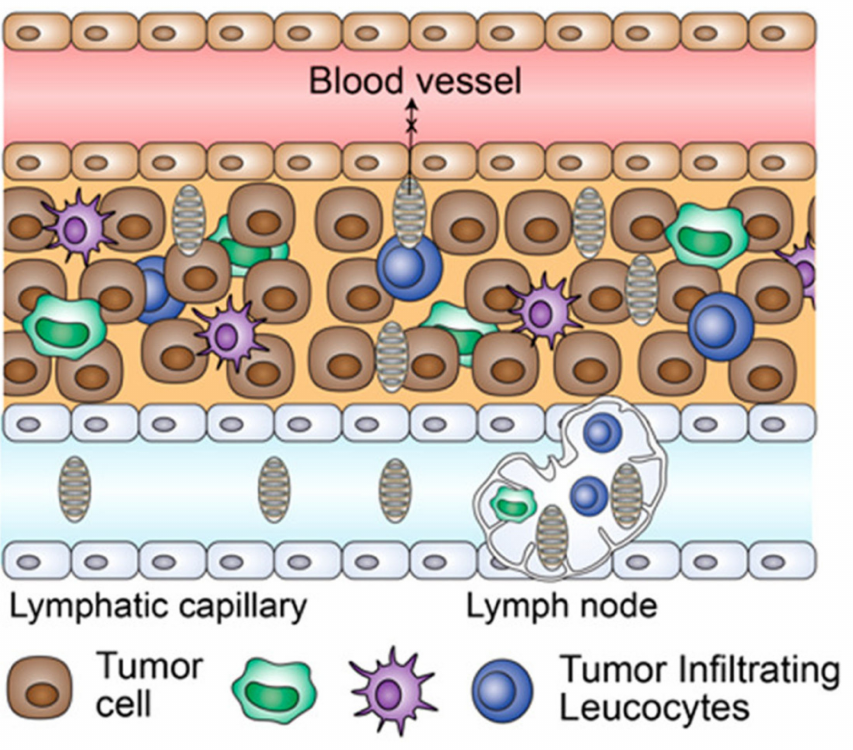
Figure 4. Multicomponent TLR agonist assembly (MTA) treatment could enhance the migration and mobility of tumor-infiltrating leukocytes (TIL) to tumor microenvironment. Reproduced with permission from ref. [82]. 2020 American Chemical